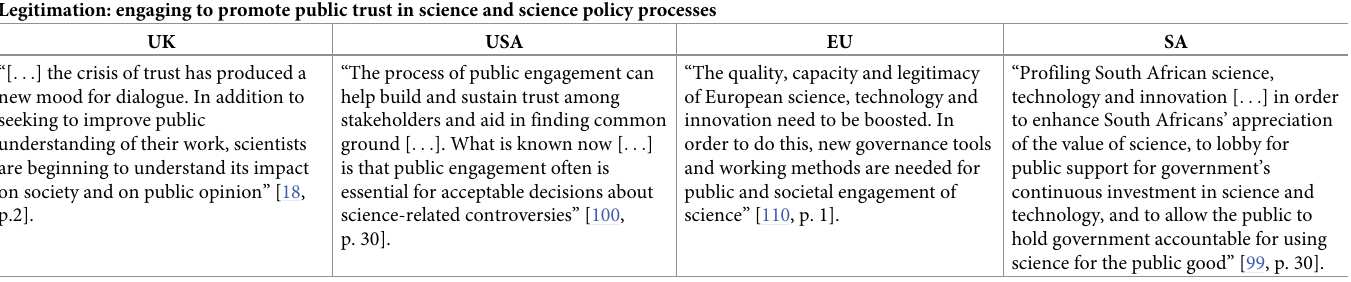
Table 6. Legitimation as motivation for engagement in policy documents.